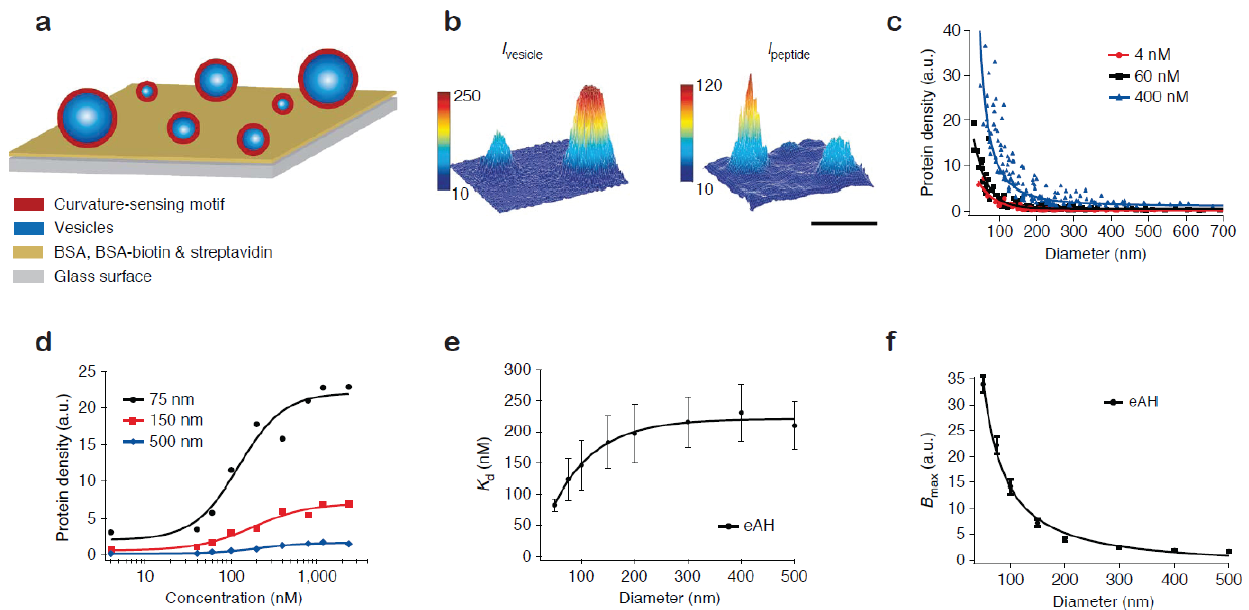
Figure 2. Screening of membrane curvature dependent protein-lipid